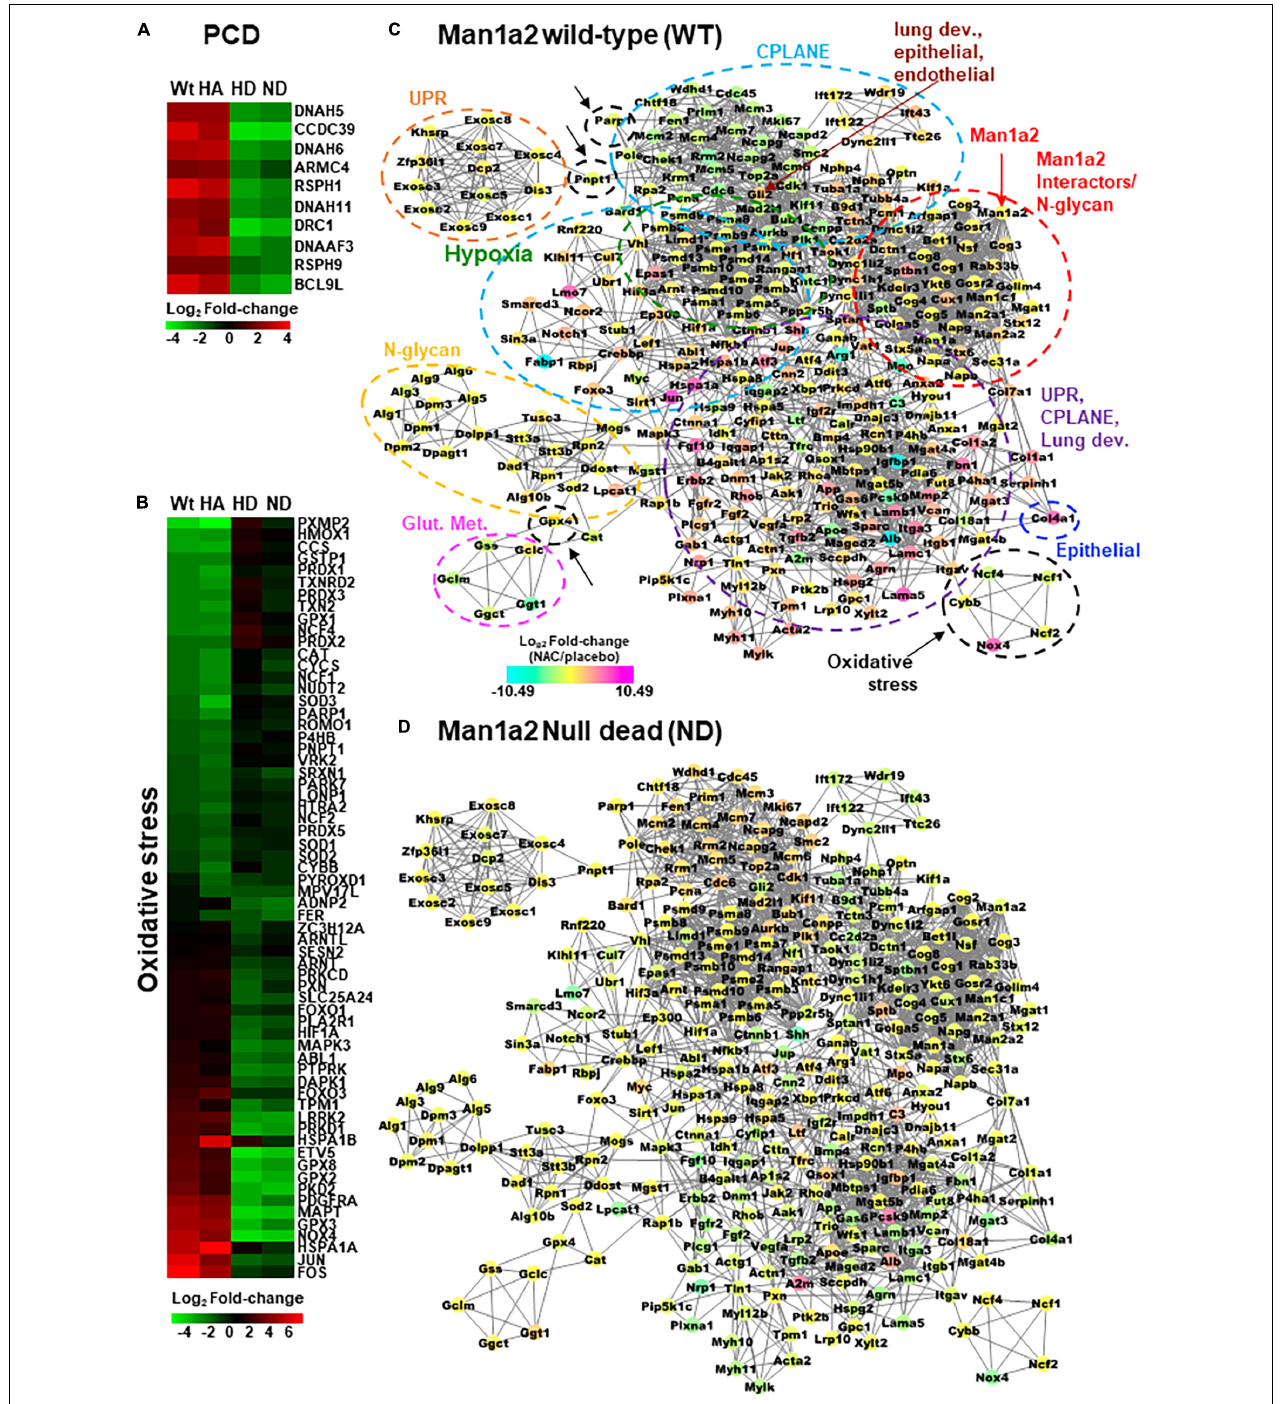
FIGURE 4 | Heatmaps with differentially expressed (A) primary ciliary dyskinesia genes and (B) selected oxidative stress genes in NAC-treated Man1a2 pups. Protein-protein interaction (PPI) network with 297 of 847 proteins corresponding to differentially expressed genes in lungs from NAC-treated (C) wild type (WT) and (D) Man1a2 null dead (ND) pups. Illustrative heatmaps show differentially expressed (A) primary ciliary dyskinesia genes and (B) selected oxidative stress genes in NAC-treated pups. Dashed circles in (C) identify functional clusters: Man1a2-interactors and N-glycan synthesis (red with arrow), oxidative stress (black with arrows), hypoxia signaling (green), glutathione metabolism (Glut. Met., pink), unfolded protein response (UPR, orange), N-glycan synthesis (yellow), Epithelial tube morphogenesis (blue), and multifunctional cluster (UPR, CPLANE and lung development (purple). Gli2 (maroon arrow) is a key gene in lung epithelial, and endothelial tube development. Multiple clusters circled by light blue dashed lines consist of CPLANE proteins. Node colors indicate the mRNA expression in log 2 Fold-change: down regulated genes are in cyan, upregulated genes are in magenta and no log2 fold-change genes are in yellow color.